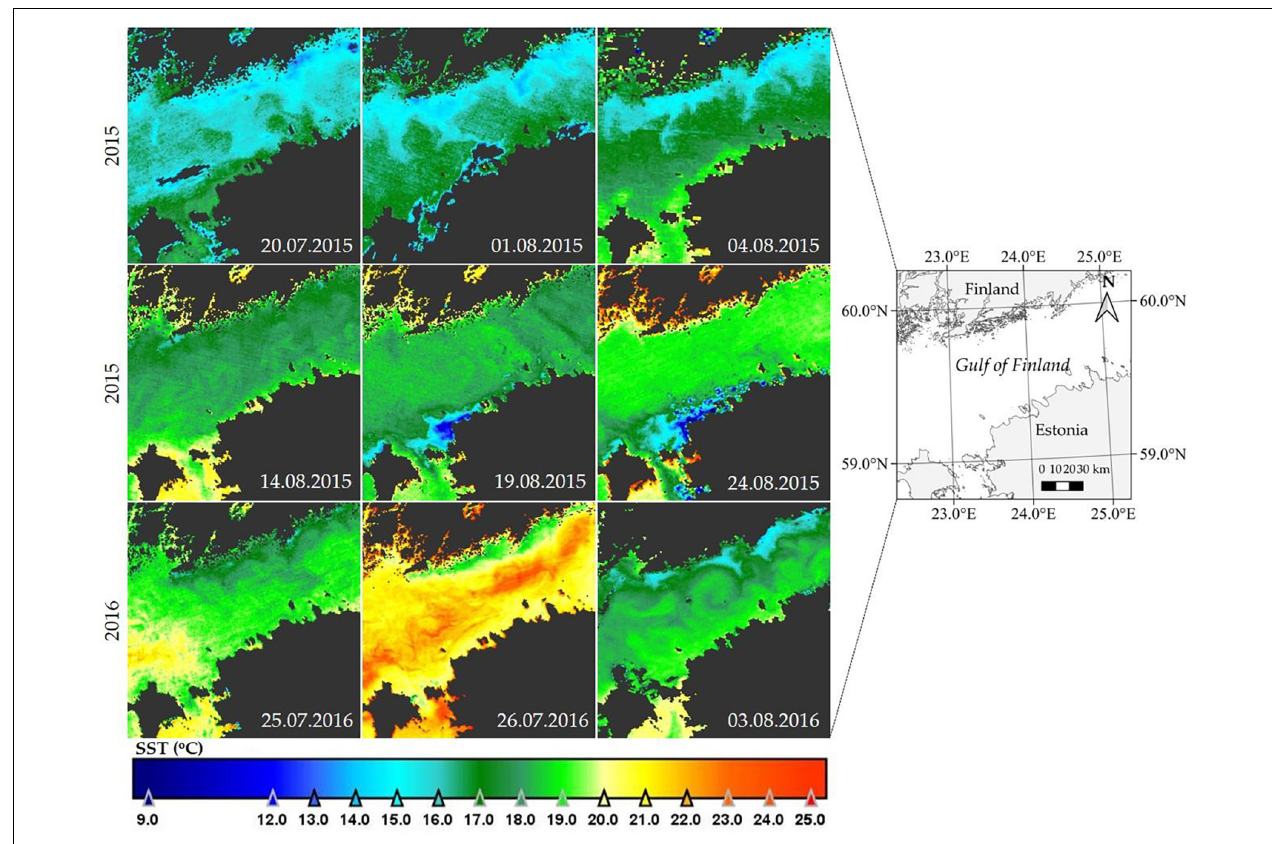
FIGURE 2 | Sea Surface Temperature (SST) maps from MODIS data for the 2015 and 2016 monitoring period. Coastal upwelling regions with lower surface temperature can be